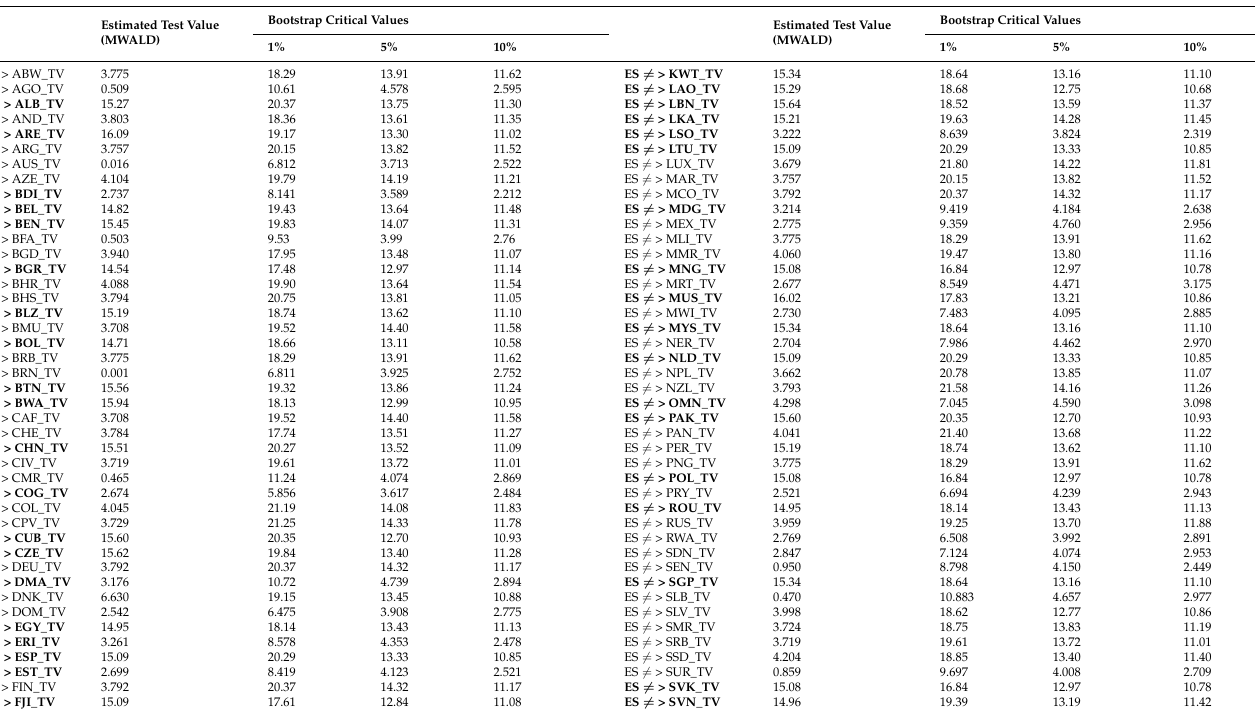
volume of Bitcoin